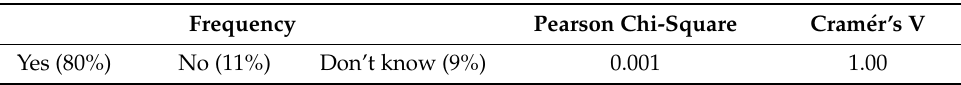
Table 14. refer back to Figure 4.